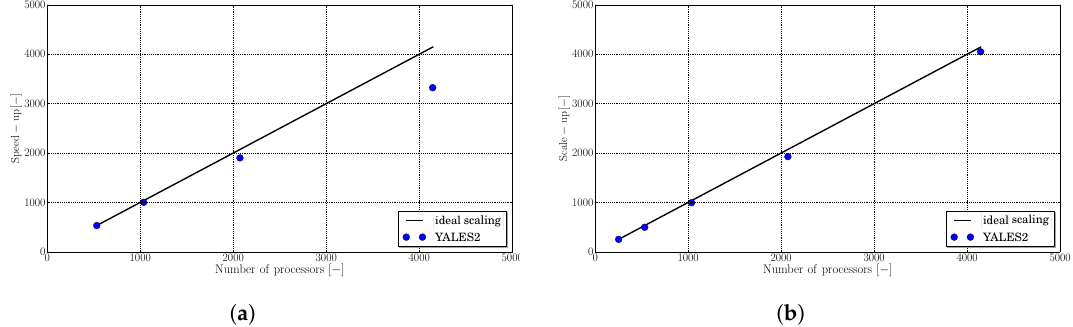
Figure 7. Speed-up ( a ) and scale-up ( b ) curves extracted from the canonical